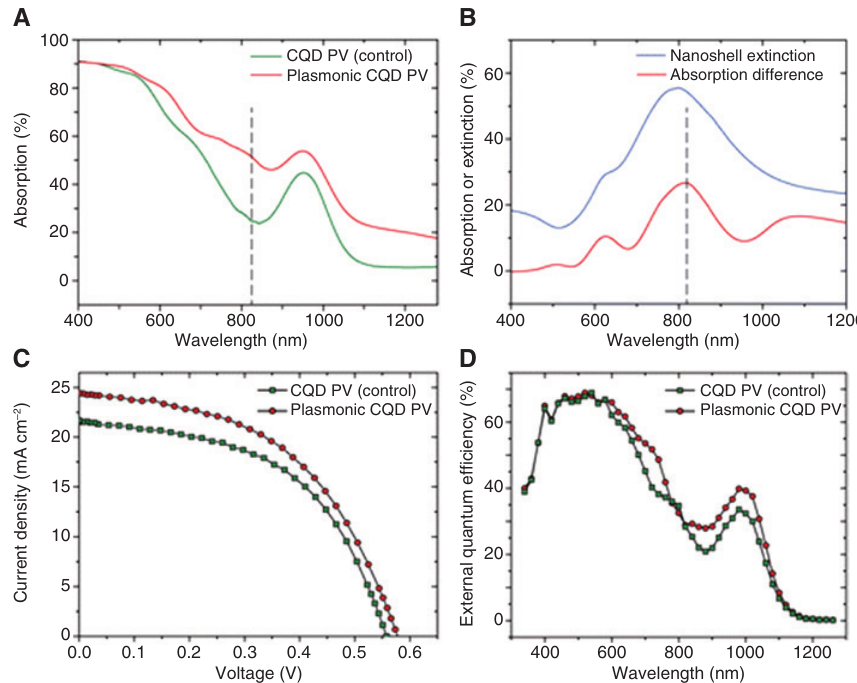
Figure 24: Effect of gold nanoshells on the performance of PbS colloidal QD photovoltaic devices (QD PV). (A) Increase in absorption in a QD PV with incorporation of nanoshells. (B) Difference in absorption of (A) compared to absorption of free nanoshells. (C) Current-voltage characteristics and (D) external quantum efficiency for QD PV with and without plasmonic nanoshells present. Photocurrent efficiency enhancement of 11% was seen. Reprinted with permission from Ref. [191]. Copyright 2013 American Chemical